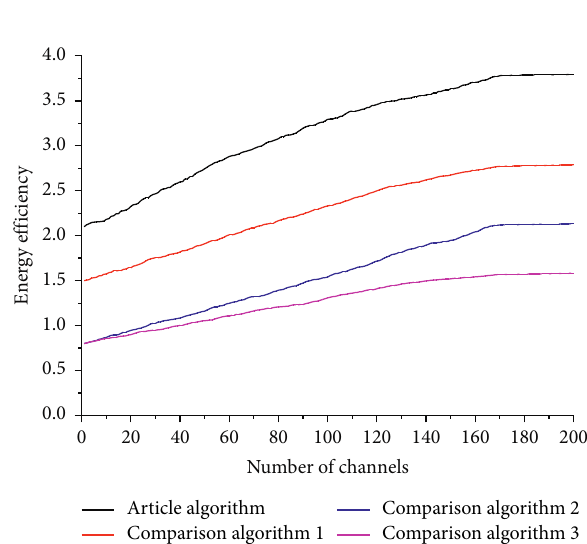
Figure 8: Energy efficiency versus the number of channels N